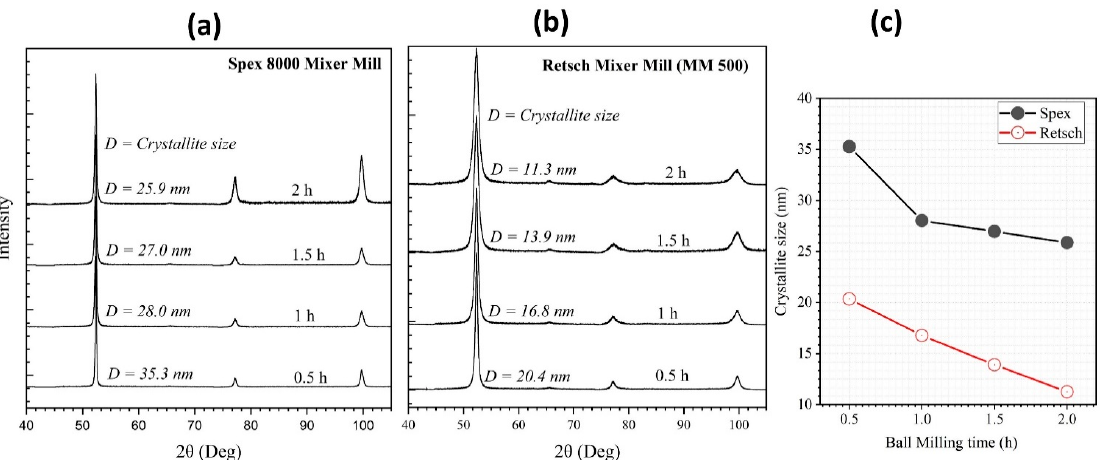
Figure 4. Comparison of mechanical alloying—( a , b ) represent XRD (X-Ray Diffraction) plots showing peak broadening from the {110} plane (2 θ ≈ 52 ◦ ) of the metal powders using either the Spex or Retsch mill, respectively, and ( c ) the change in the crystallite size (Scherrer analysis) with milling time by each mill.